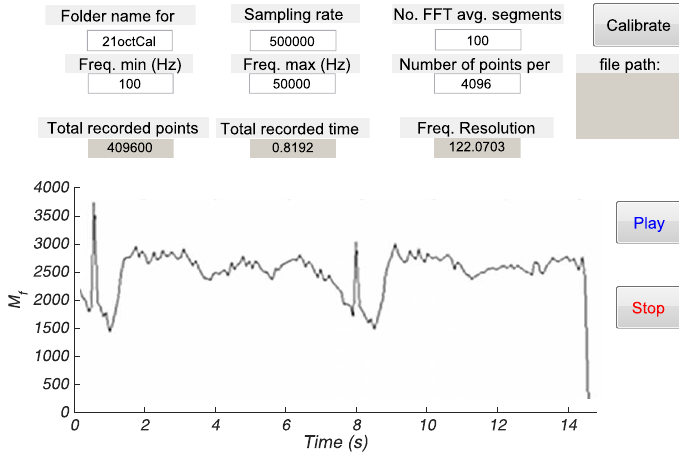
Figure 16. Graphic user interface with real-time monitoring of the instantaneous flow with the pump’s potentiometer at the minimal value similar to Figure